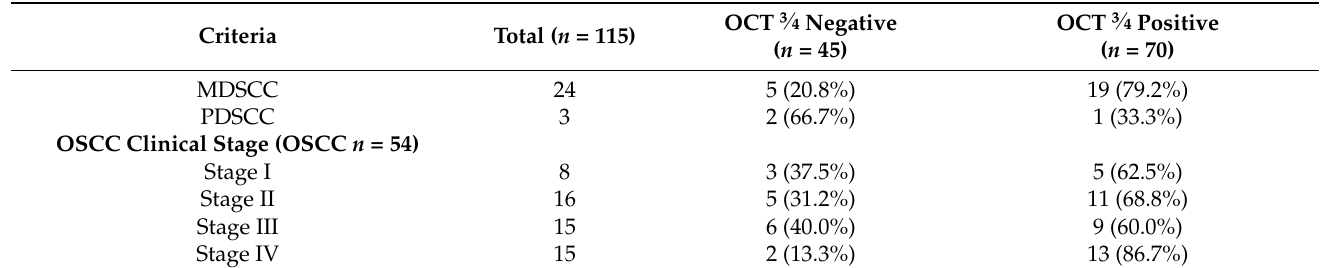
Figure 1. ( a ) IHC for OCT 3/4 in healthy control hyperplastic oral epithelium, showing negative stain, ( b ) IHC for OCT 3/4 in oral submucous fi brosis showing intense nuclear positivity, and ( c )